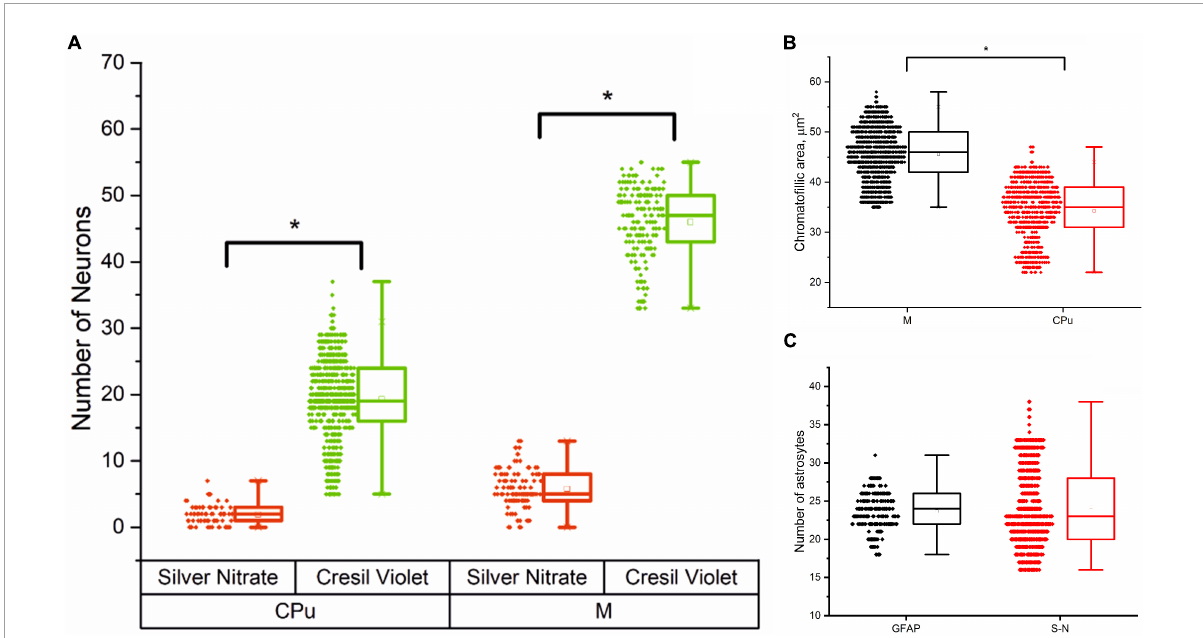
FIGURE3 Cells morphometry in the motor cortex (M) and striatum (CPu) in male rats, Me (25L; 75U). (A) Number of silver nitrate impregnated and cresyl violet-stained neurons in the striatum (CPu) and motor cortex (M); (B) Average chromatophilic substance area per cell, µ m 2 in the motor cortex (M) and striatum (CPu); (C) Number of silver nitrate impregnated (S-N) and GFAP-positive (GFAP) astrocytes in the motor cortex.